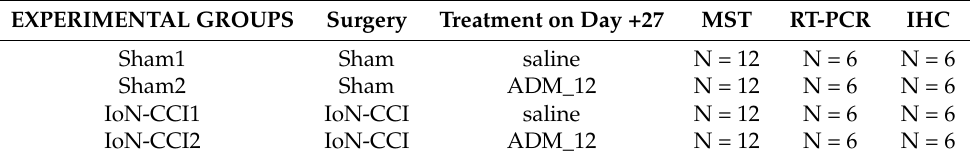
Table 2. Experimental groups and number (N) of animals per group that underwent the mechanical stimulation test (MST). The samples of the subsets were processed for the real time polymerase chain reaction (RT-PCR) or immunohistochemistry (IHC).